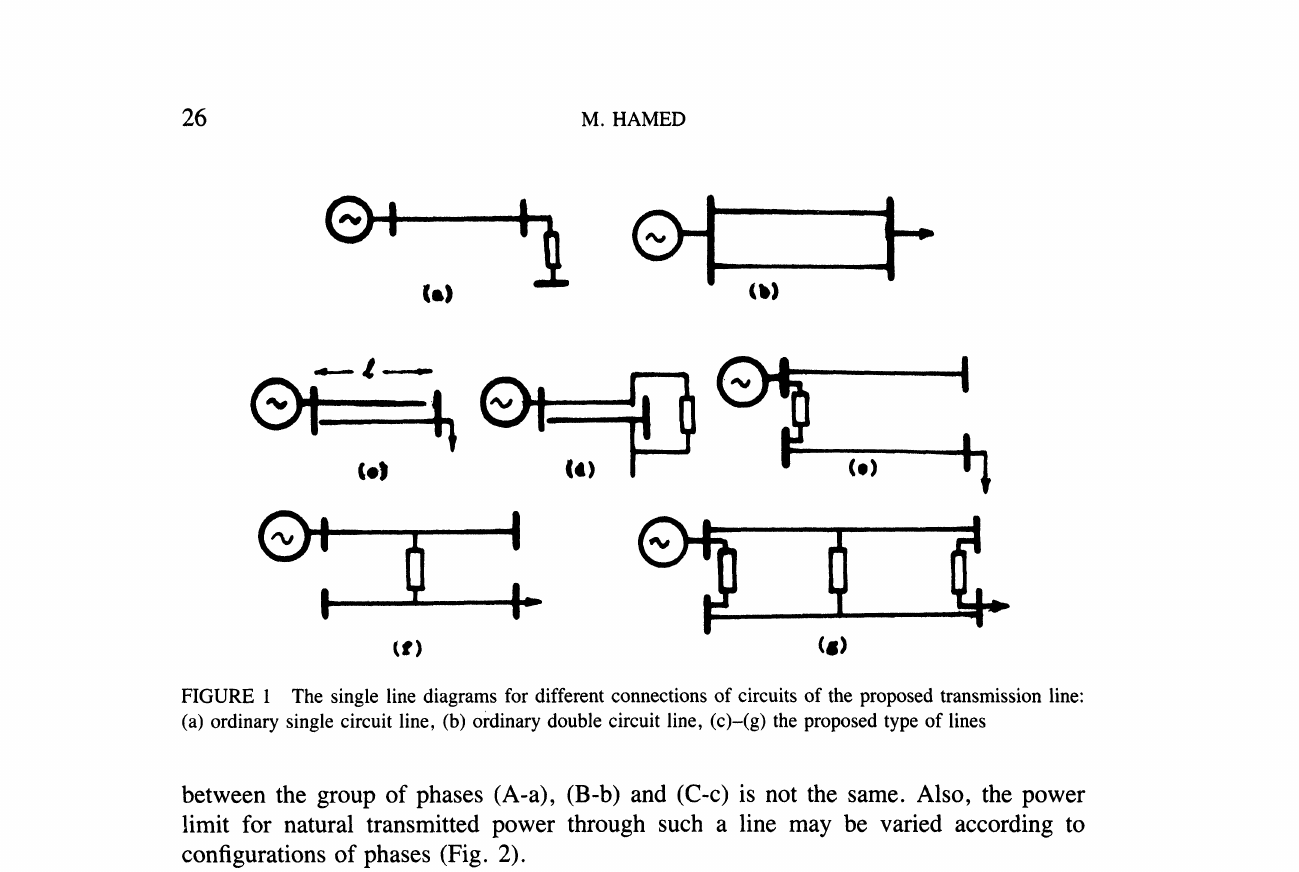
The single line diagrams for different connections of circuits of the proposed transmission line: (a) ordinary single circuit line, (b) ordinary double circuit line, (c)-(g) the proposed type of lines between the group of phases (A-a), (B-b) and (C-c) is not the same. Also, the power limit for natural transmitted power through such a line may be varied according to configurations of phases (Fig.